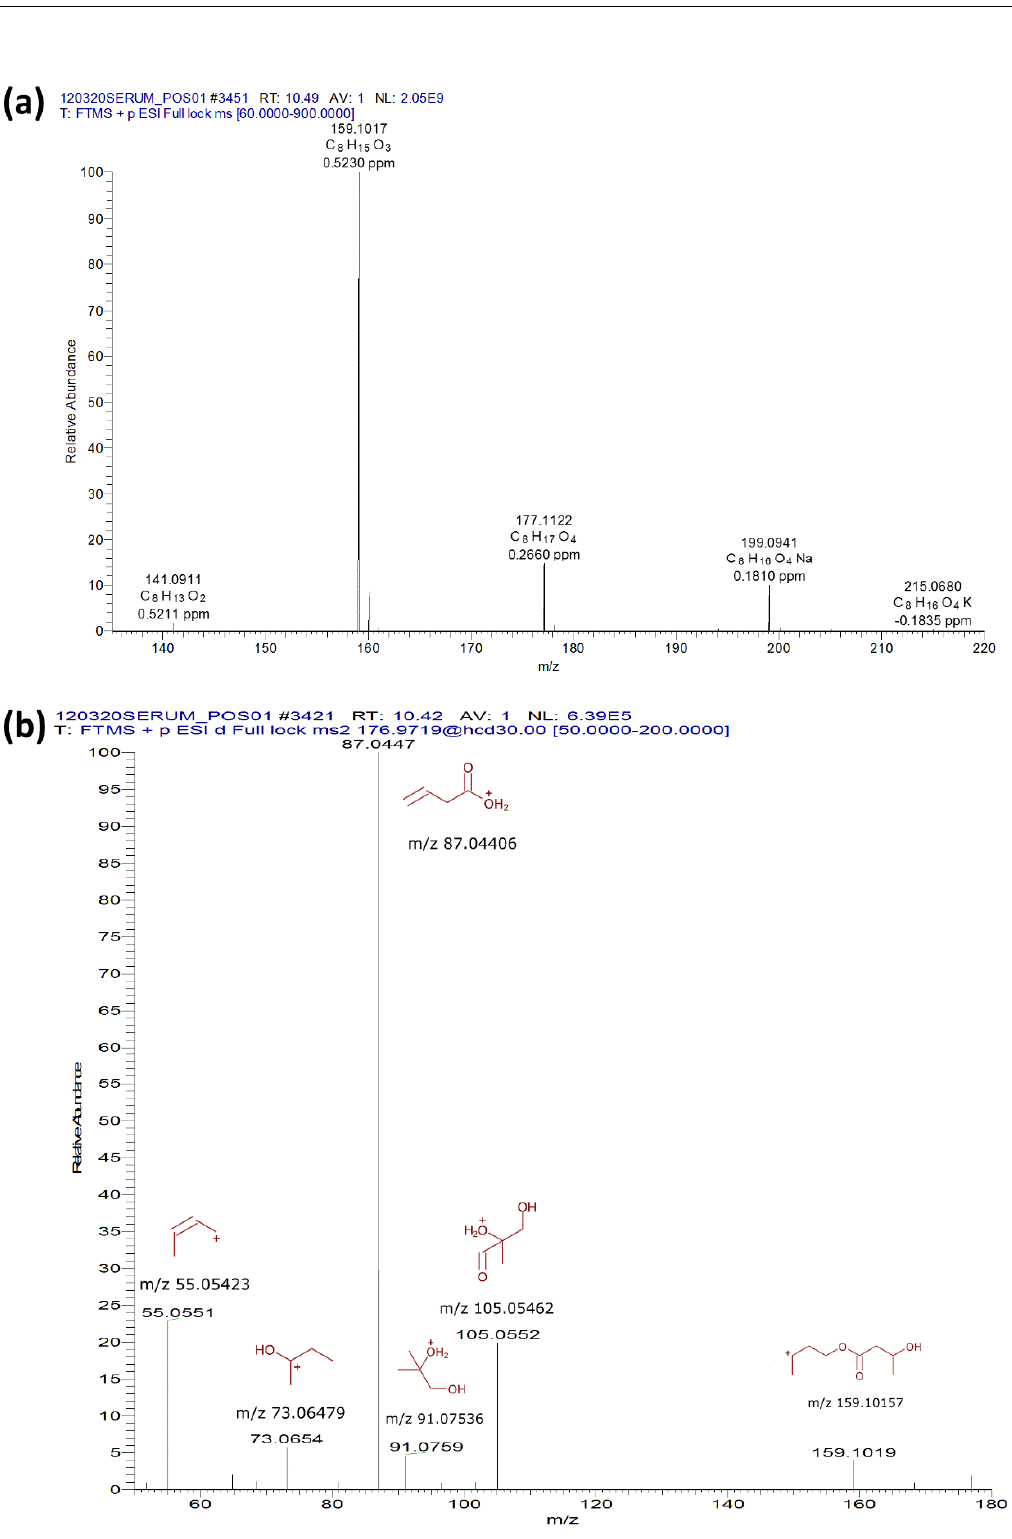
Figure 2. LC-MS identification of (R)- β -hydroxybutyrate and (R)-1,3-butanediol. The LC-MS identification of the KE was validated by the presence of adducts ([M+H − H 2 O] + , [M+H − 2H 2 O] + , [M+Na] + and [M+K] + ) ( a ) and a MS/MS fragmentation modeled in Mass Frontier 8.0 (Slovakia) ( b ).